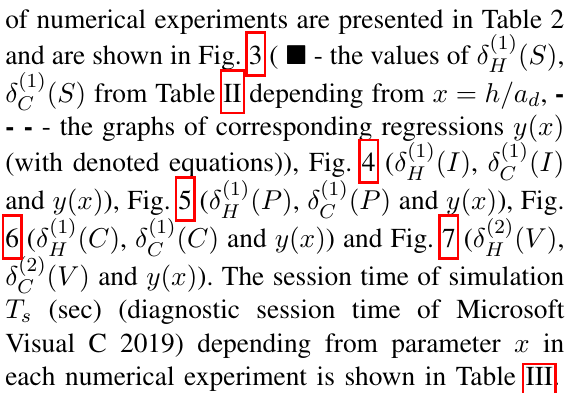
Fig. 3. (cid:4) - values of δ (1) regressions y ( x ) , x = h/a d .